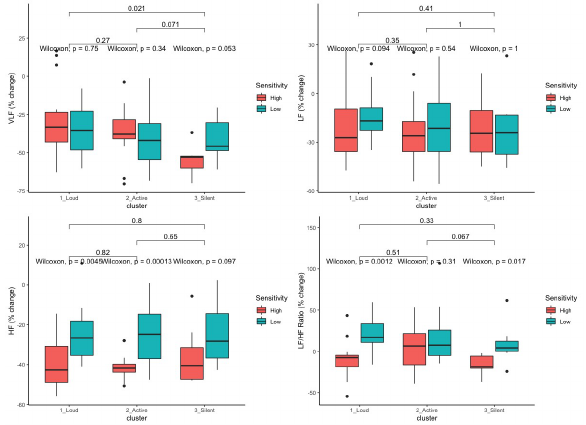
Figure 9: Relative change (%) in frequency domain HRV parameters for high and low noise sensitivity